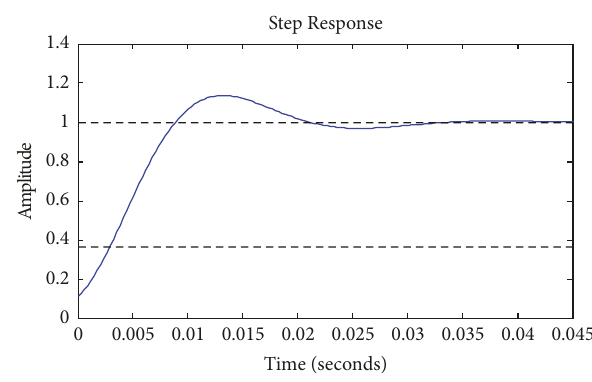
Figure 18: Step response of the